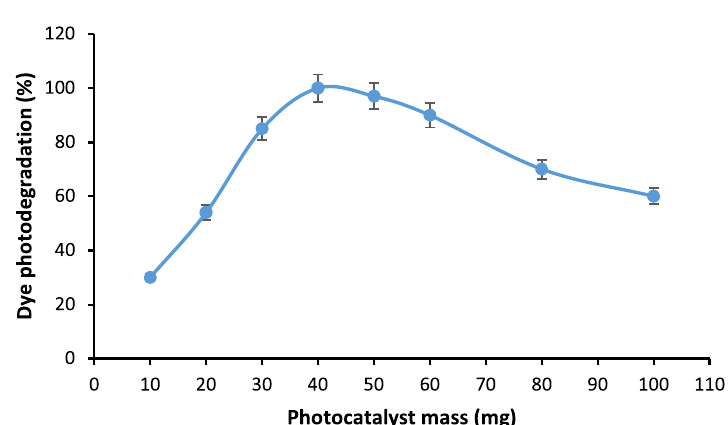
Fig. 9 Effect of the photocatalyst mass on the dye photodegradation over TiO 2 – Fe (1:0.5) under visible light. (Dye concentration